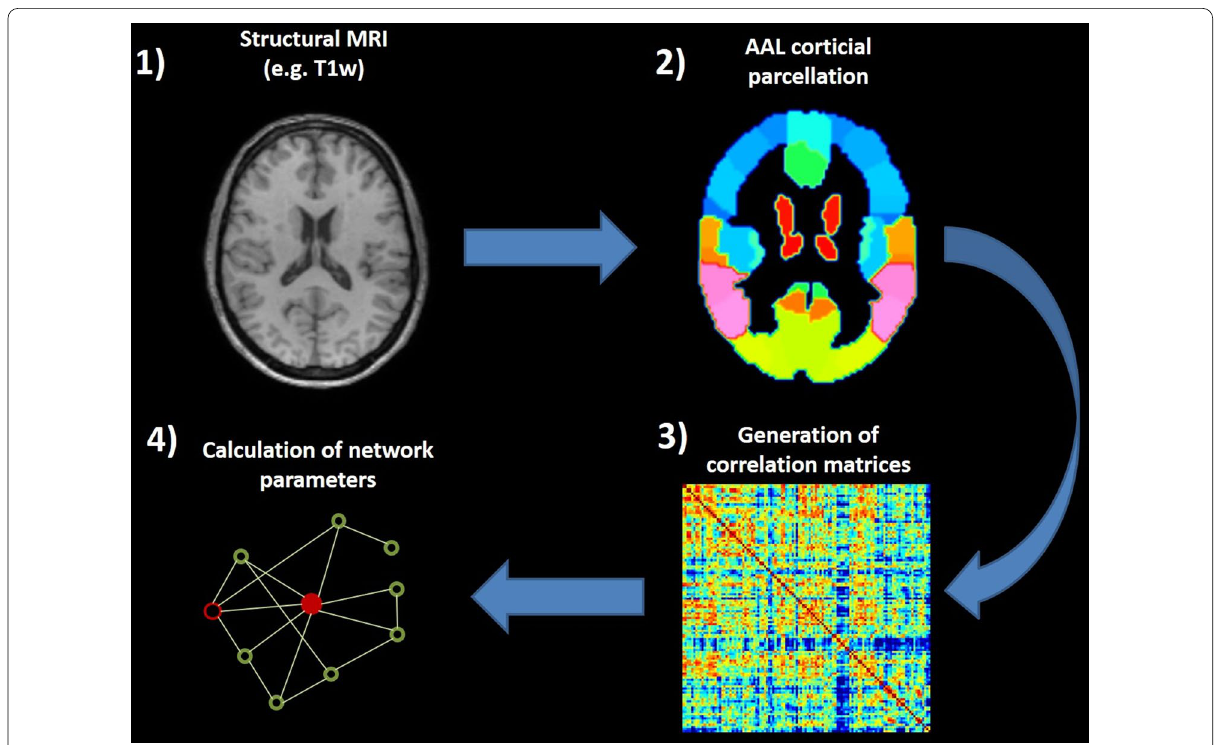
Fig. 1 Flowchart of the graph theoretical network analysis. AAL: automated anatomical